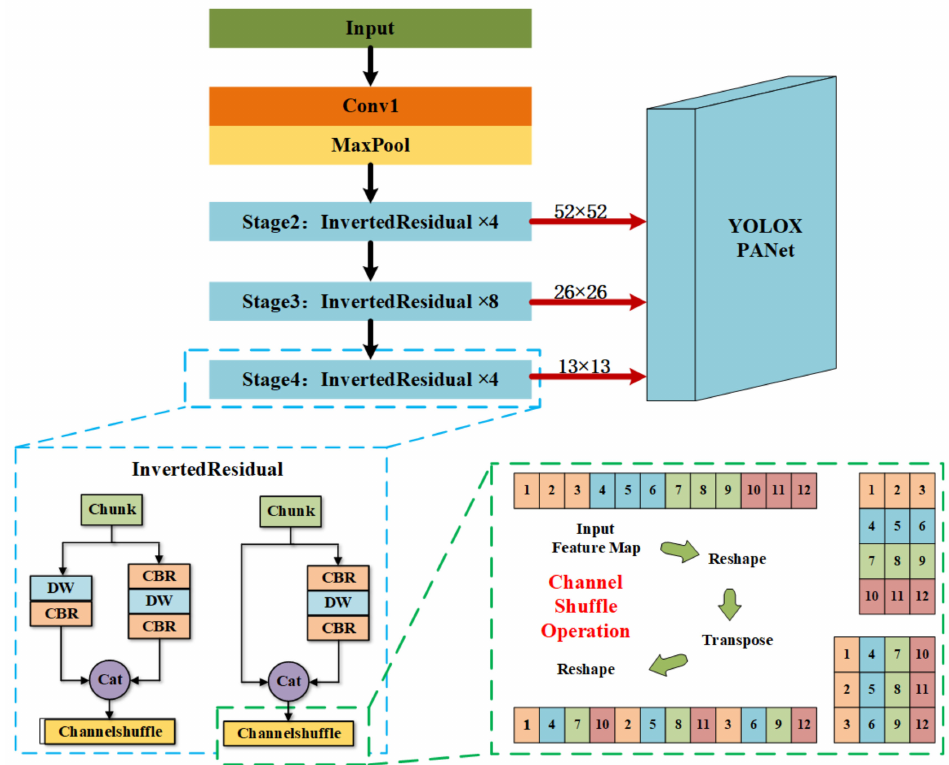
Figure 4. Shufflenetv2 network